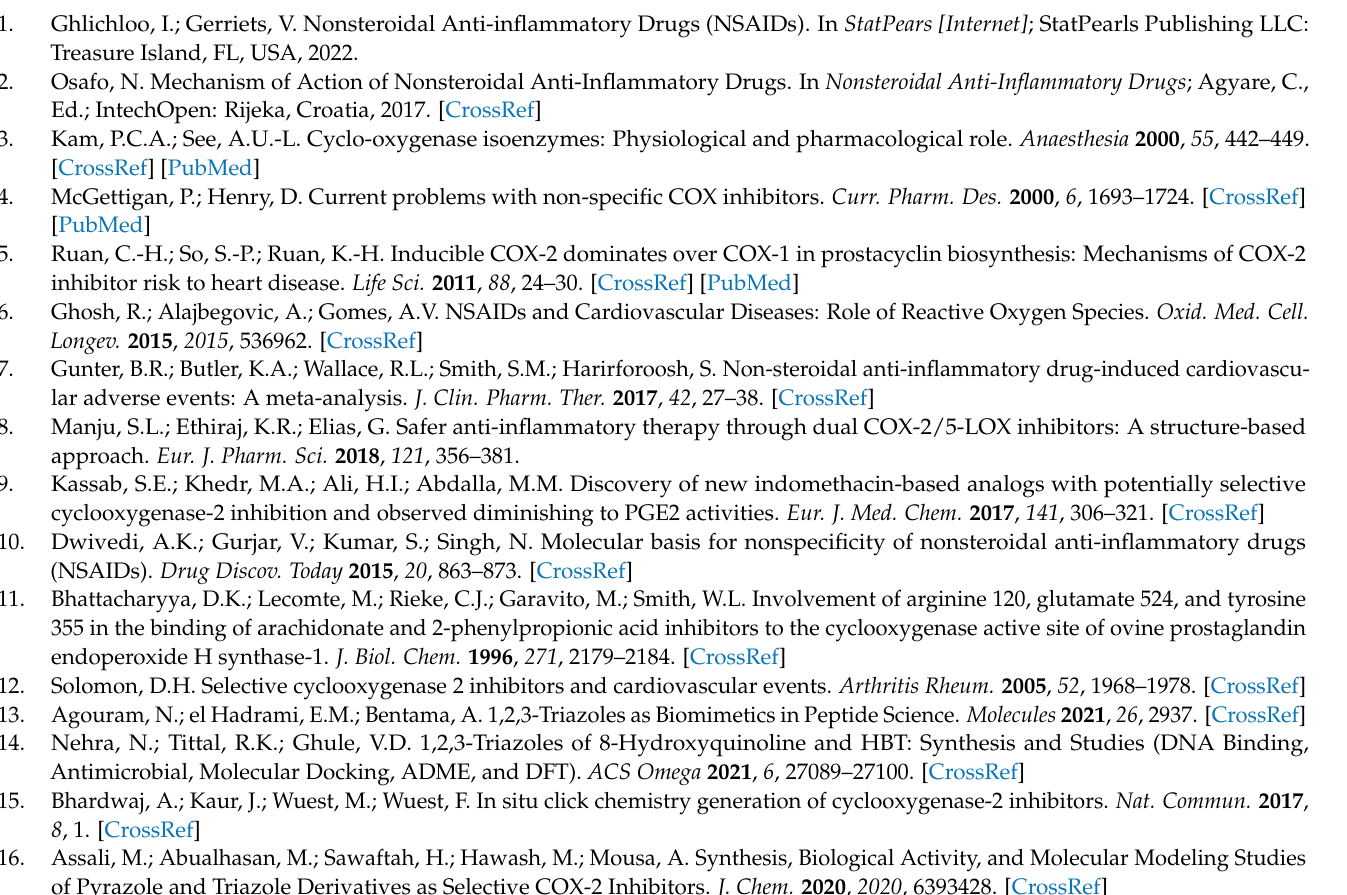
of ( 6h ); Figure S13: 1 H-NMR spectrum of ( 6i ); Figure S14: 1 H-NMR spectrum of ( 6j ); Figure S15: 13 C-NMR spectrum of ( 1c ); Figure S16: 13 C-NMR spectrum of ( 4d ); Figure S17: 13 C-NMR spectrum of ( 6a ); Figure S18: 13 C-NMR spectrum of ( 6b ); Figure S19: 13 C-NMR spectrum of ( 6e ); Figure S20: 13 C-NMR spectrum of ( 6f ); Figure S21: 13 C-NMR spectrum of ( 6h ); Figure S22: 13 C-NMR spectrum of ( 6i ); Figure S23: EI-MS spectrum of ( 6b ); Figure S24: EI-MS spectrum of ( 6f ); Figure S25: EI-MS spectrum of ( 6j